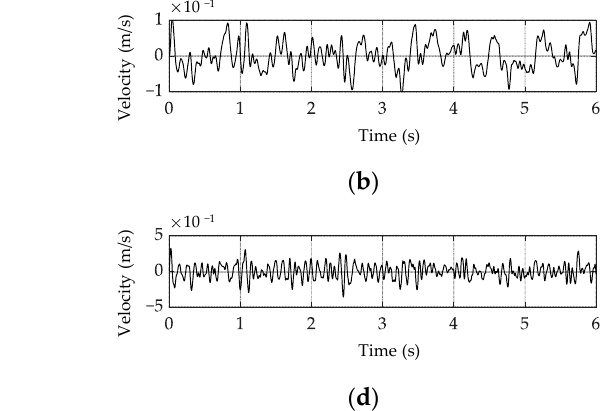
. . . . z s 1 ; ( b ) z s 2 ; ( c ) z u 1 ; and ( d ) z u 2 .